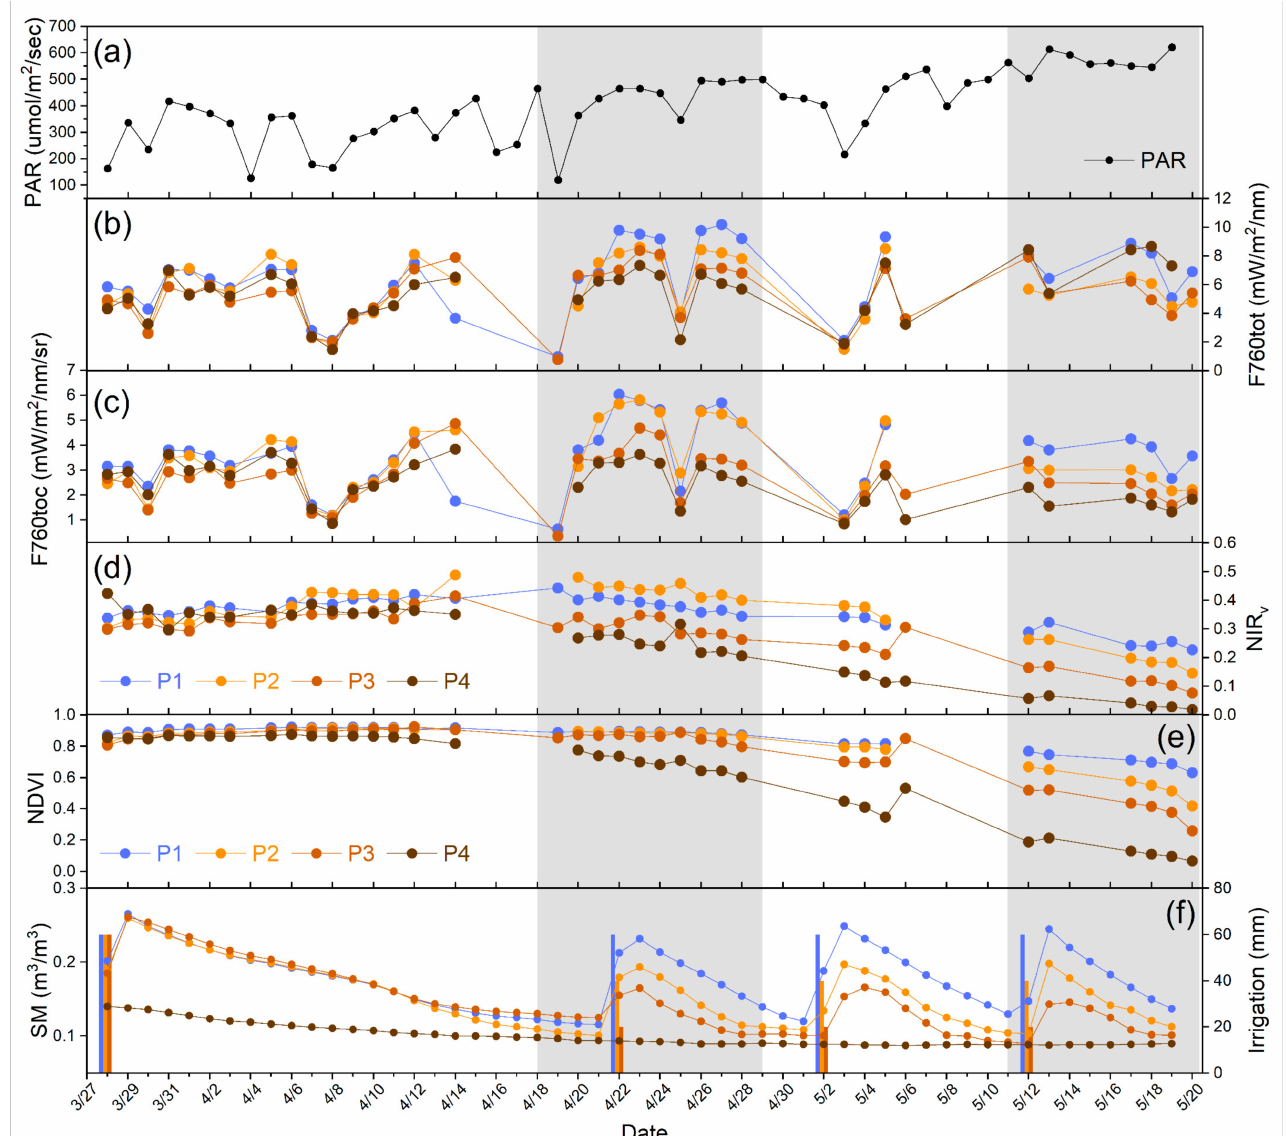
Figure 4. Seasonal patterns of ( a ) PAR, ( b ) F760tot, ( c ) F760toc, ( d ) NIR v , ( e ) NDVI, and ( f ) SM and irrigation. Each dot line represents the daily mean value of the measurements, with blue dots for plot 1 (P1) and orange to dark black for plots 2–4 (P2–P4). Gray transparent rectangles in panels ( a – c ) indicate the different response period of SIF and VIs to different drought